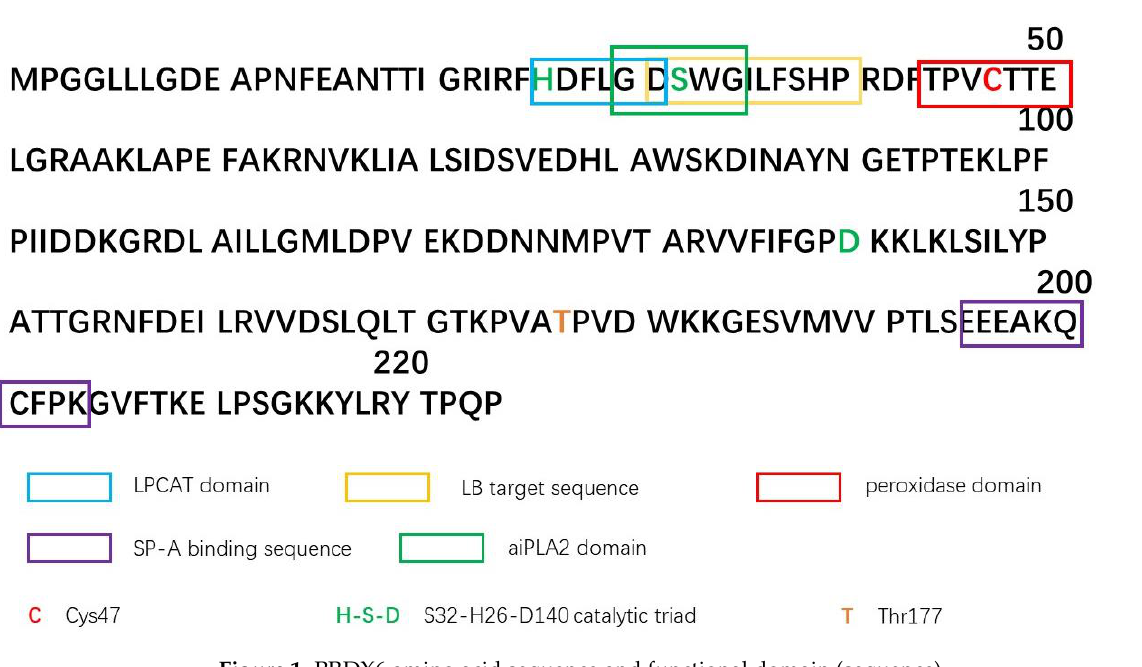
Figure 1. PRDX6 amino acid sequence and functional domain (sequence).